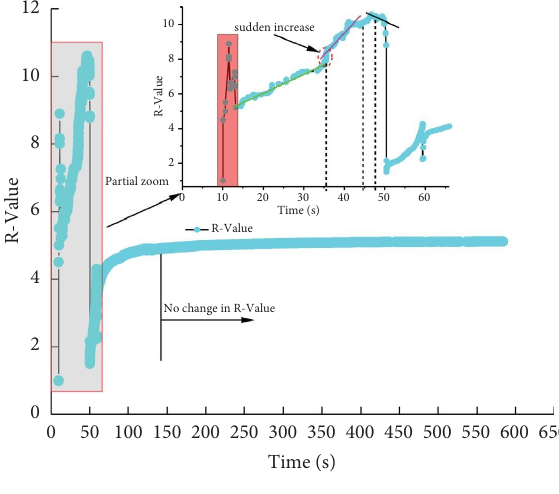
Figure 8: Variation curve of R value in the whole loading